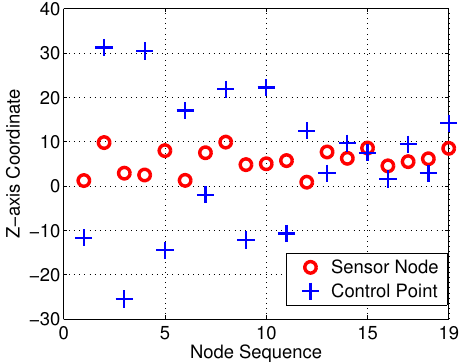
Figure 10. Sensor nodes and control points of Bezier